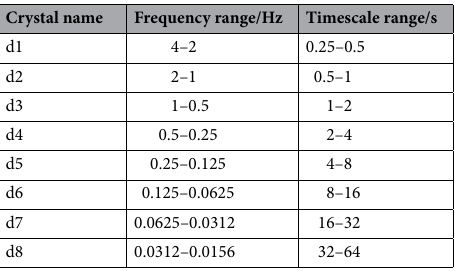
Table 1. Frequency and timescale ranges for sampling frequency 4